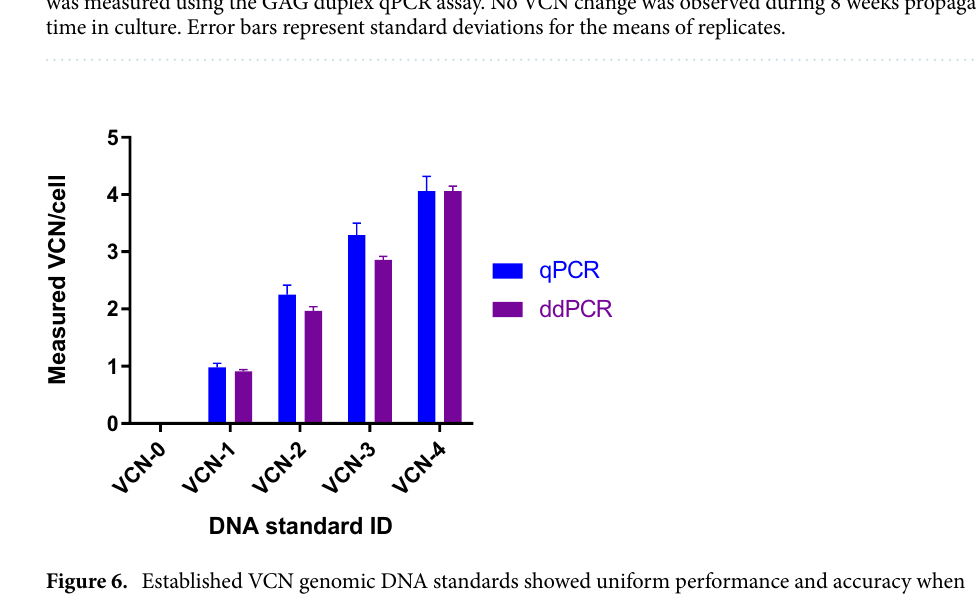
Figure 6. Established VCN genomic DNA standards showed uniform performance and accuracy when evaluated by independent laboratory. Genomic DNA extracted from developed VCN standard cell lines was evaluated by an independent laboratory using the RRE duplex assay for VCN determination by qPCR and ddPCR. The qPCR results represent a mean of four independent qPCR runs performed by two independent operators at NIST laboratory on two different qPCR instruments and using two different DNA inputs, with four replicates run for each condition (in total 32 qPCR data points for each tested VCN standard). The ddPCR results are concordant with the qPCR assay results and each data point represents a mean of two independent ddPCR runs performed on Bio-Rad QX200 instrument by two independent operators and using two different DNA inputs (in total 16 ddPCR data points for each tested VCN standard). The error bars are the sample standard deviations for the means of the data sets, with N = 32 for qPCR and N = 16 for the ddPCR